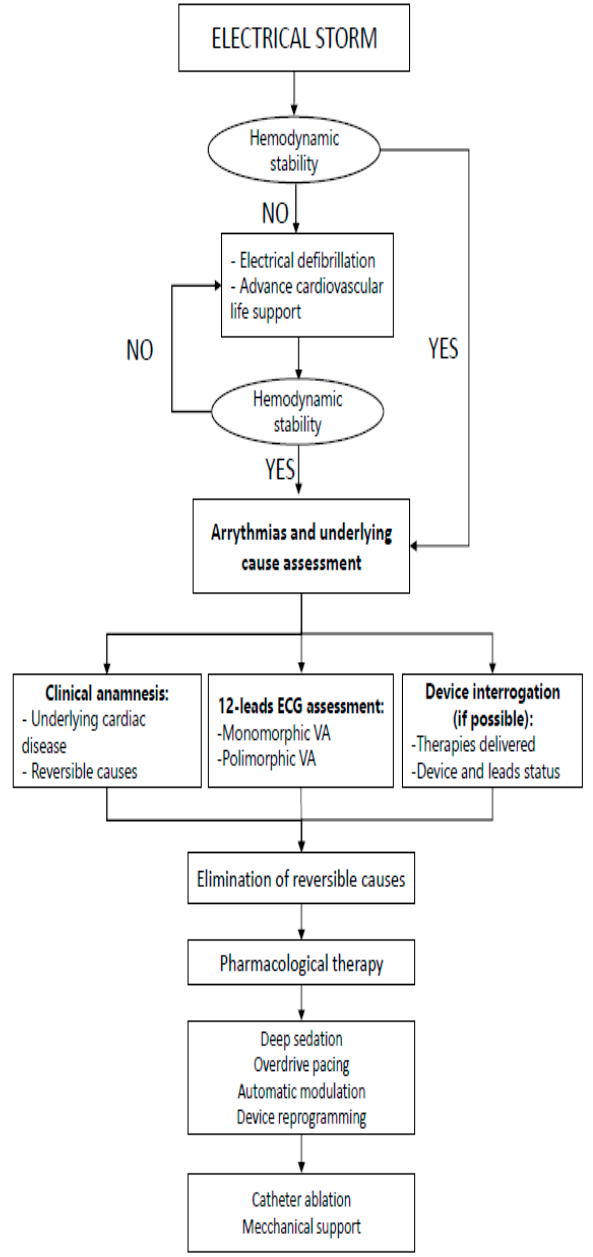
Figure 1. Flow chart of decision-making in ES , VA (Ventricular arrhythmias).